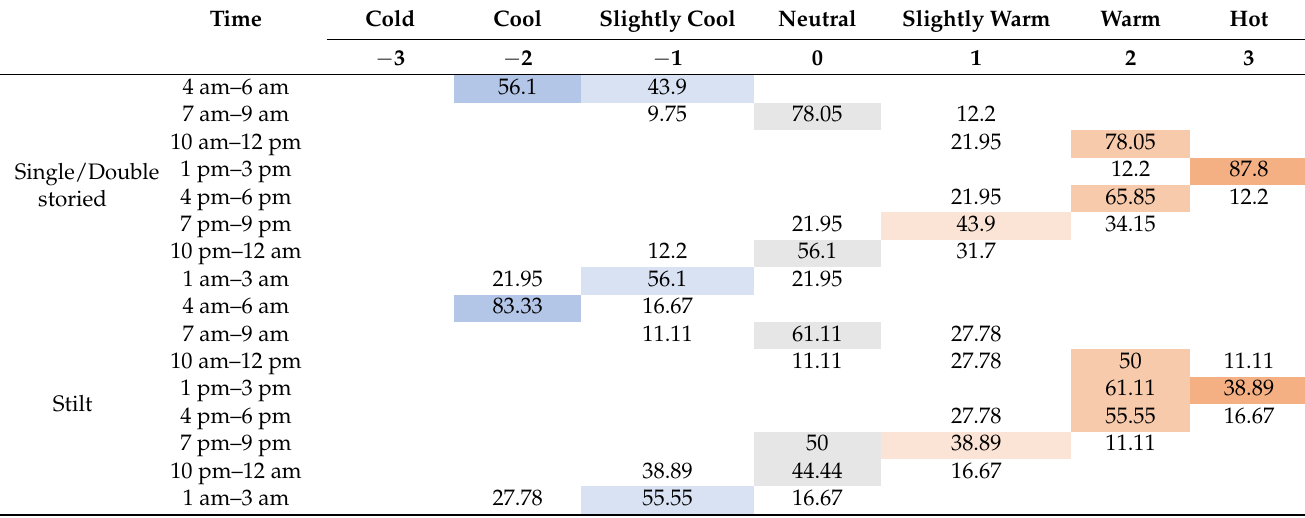
Table A2. Thermal sensation of